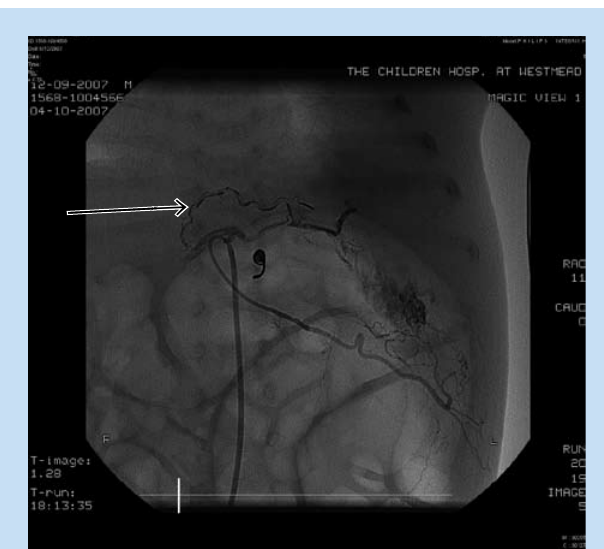
Fig. 5b. Arteriogram done during the embolisation. Onyx is seen in branches arising from the left hepatic artery (arrow). An embolisation coil was also used to occlude one of the feeder vessels. Dense contrast blush is seen in the solid component of the malformation (arrowhead).